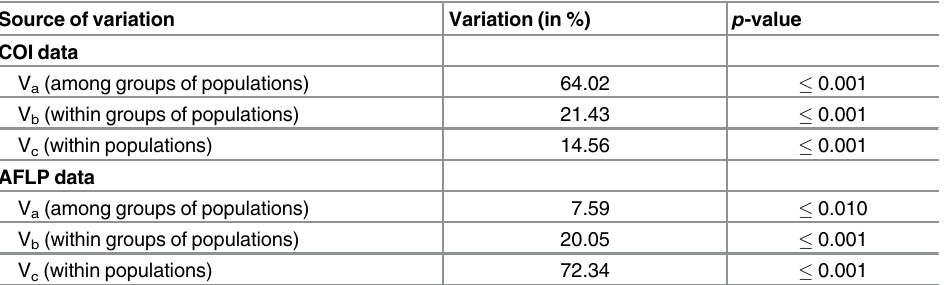
Table 2. Results of the AMOVAs for Lake Donggi Cona Radix specimens based on mtDNA and AFLP data. Groups of populations refer to lake vs. drainage populations. Source of variation